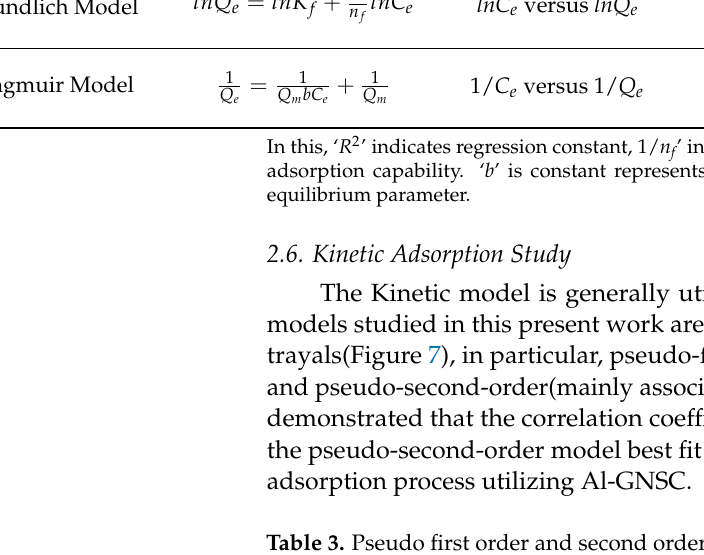
Table 3. Pseudo first order and second order data.